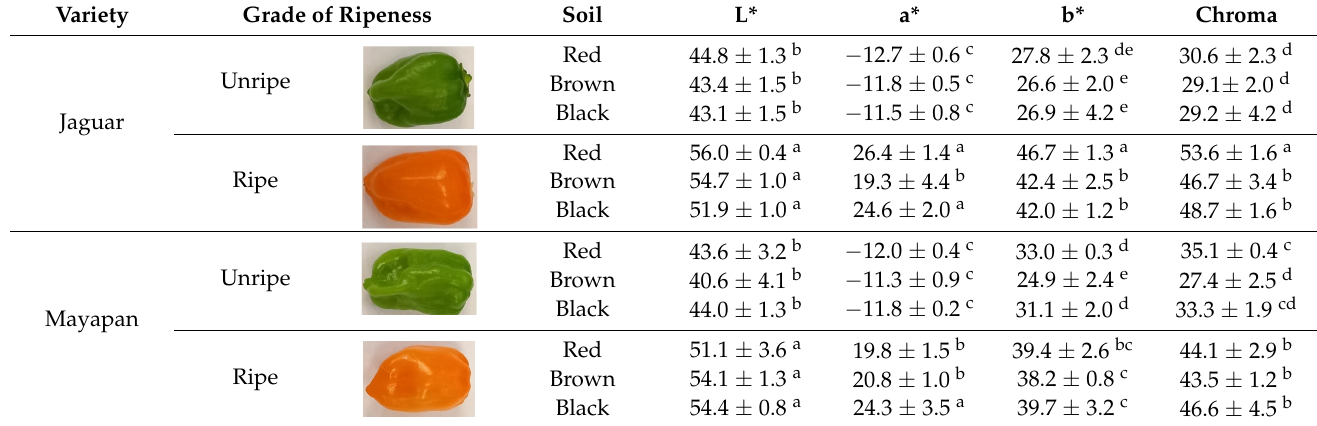
Note: L* = Lightness, a* = value relative to the green – red color, b* = value relative to the blue – yellow color (CIELAB color scale). Results followed by different letters (a – e) in the same row indicate statistically significant differences using minimum significant differences (MSD) test at p ≤ 0.05.